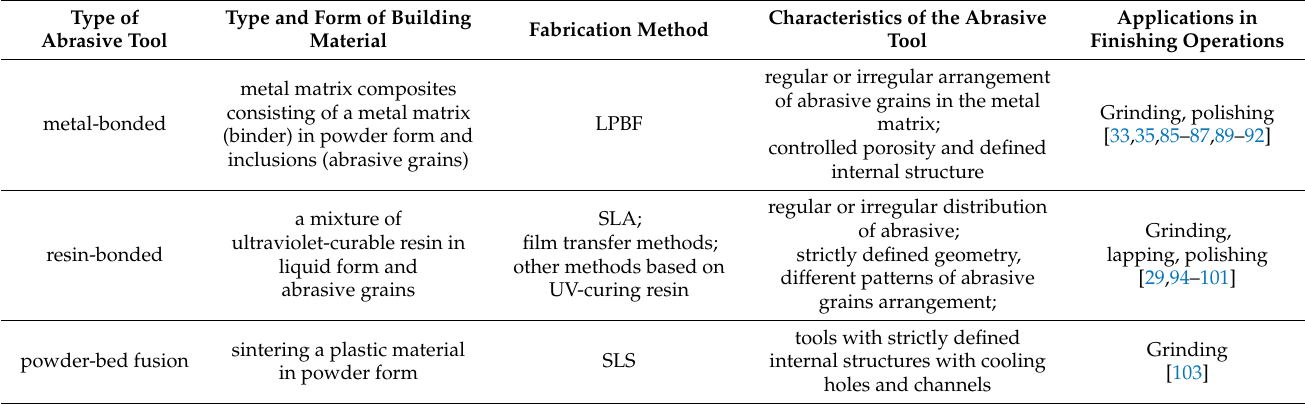
Table 3. Abrasive tools fabricated using incremental